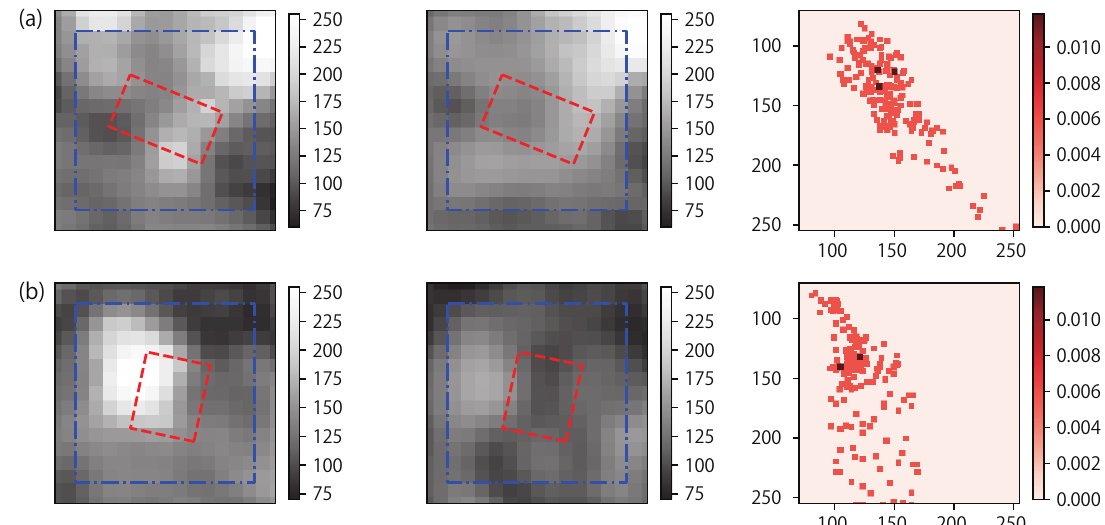
Figure 12. Illustration of three-dimensional gray level co-occurrence matrix (3DGLCM) computed on ( a ) non-washed-away and ( b ) washed-away building. The 3DGLCMs (right) were constructed from a pair of TerraSAR-X images acquired on 21 October 2010 (left) and 13 March 2011 (middle). The dashed red polygon denotes the building boundary and the dash-dotted blue square denote the window used for the construction of the 3DGLCM. The figure is modified from